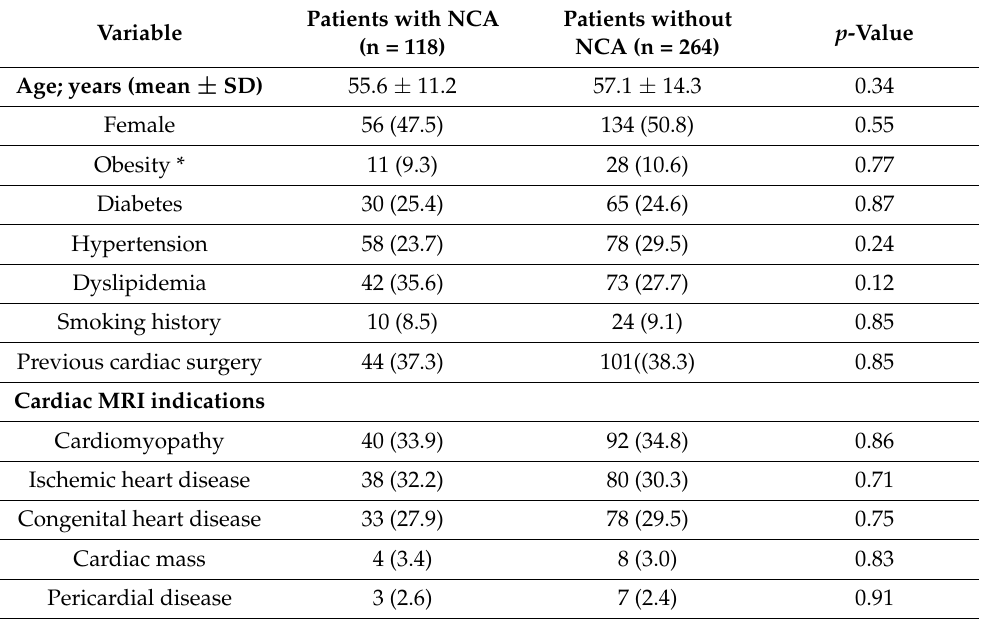
Table 1. Baseline patient characteristics and cardiac MRI